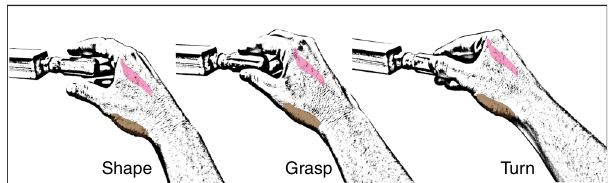
Fig. 1 Hand-manipulation task. Graphical reproduction of the motor task and its phases. The APB (abductor pollicis brevis) is shown in light brown and the FDI ( fi rst dorsal interosseous) in light